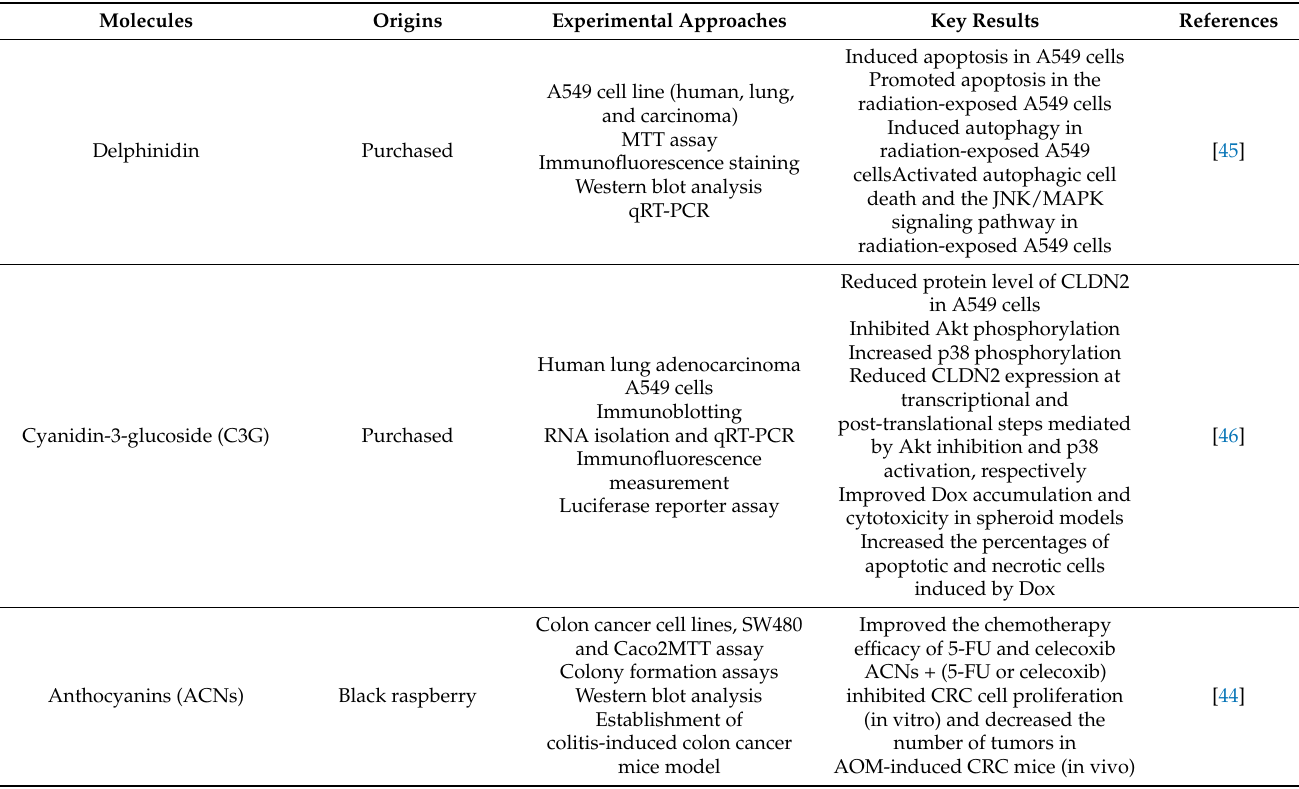
Table 2. Anthocyanidins that could enhance the chemosensitivity of cancer